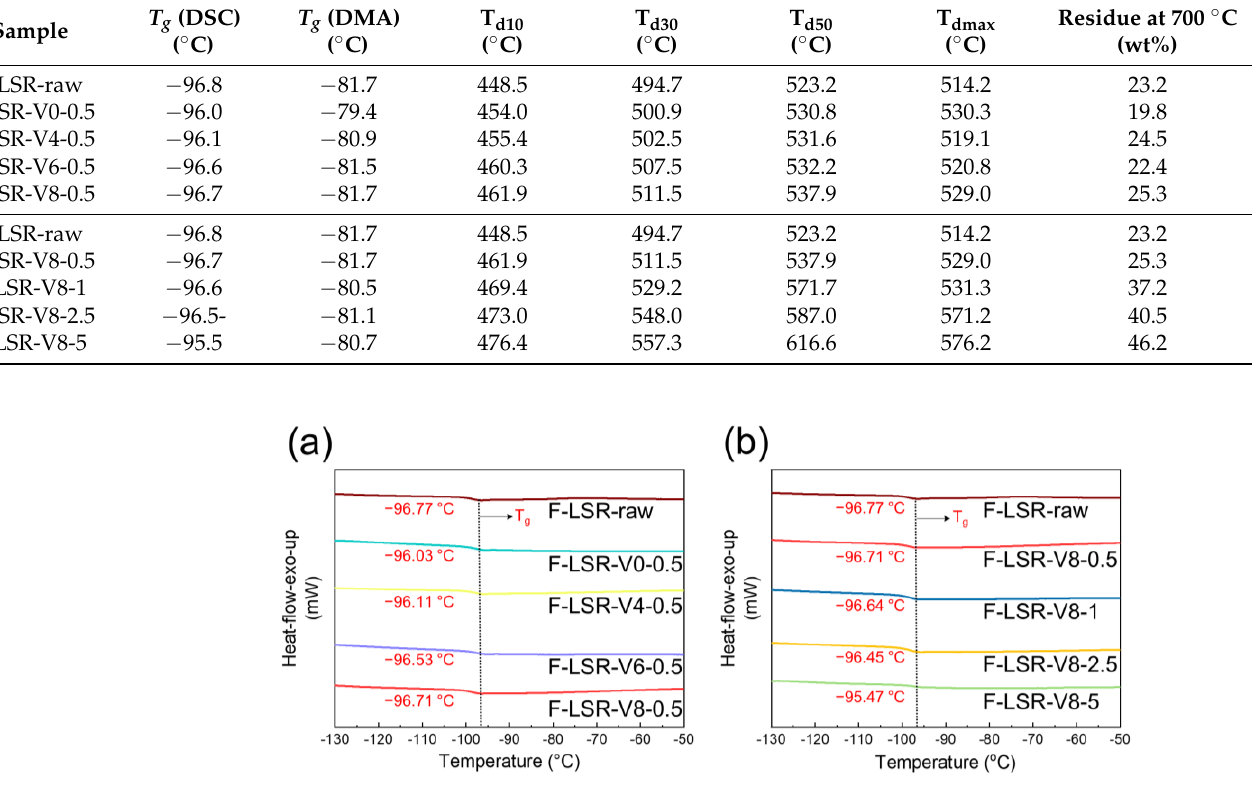
Table 4. Thermal properties of the F-LSR-POSSs obtained from DSC, DMA, and TGA analyses.